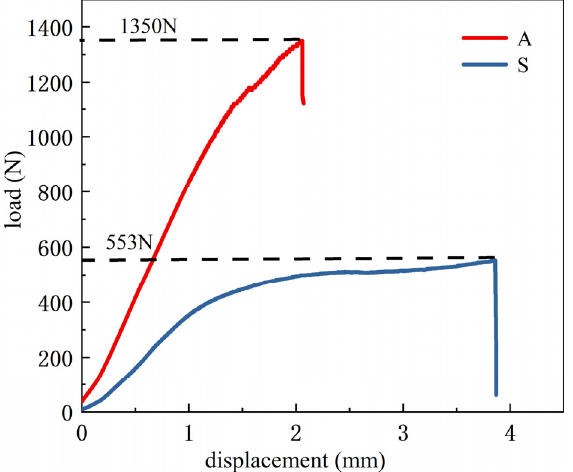
Figure 12. Flexural load-displacement curve (S denotes uniform filling structure, and A denotes adaptive-density filling structure).